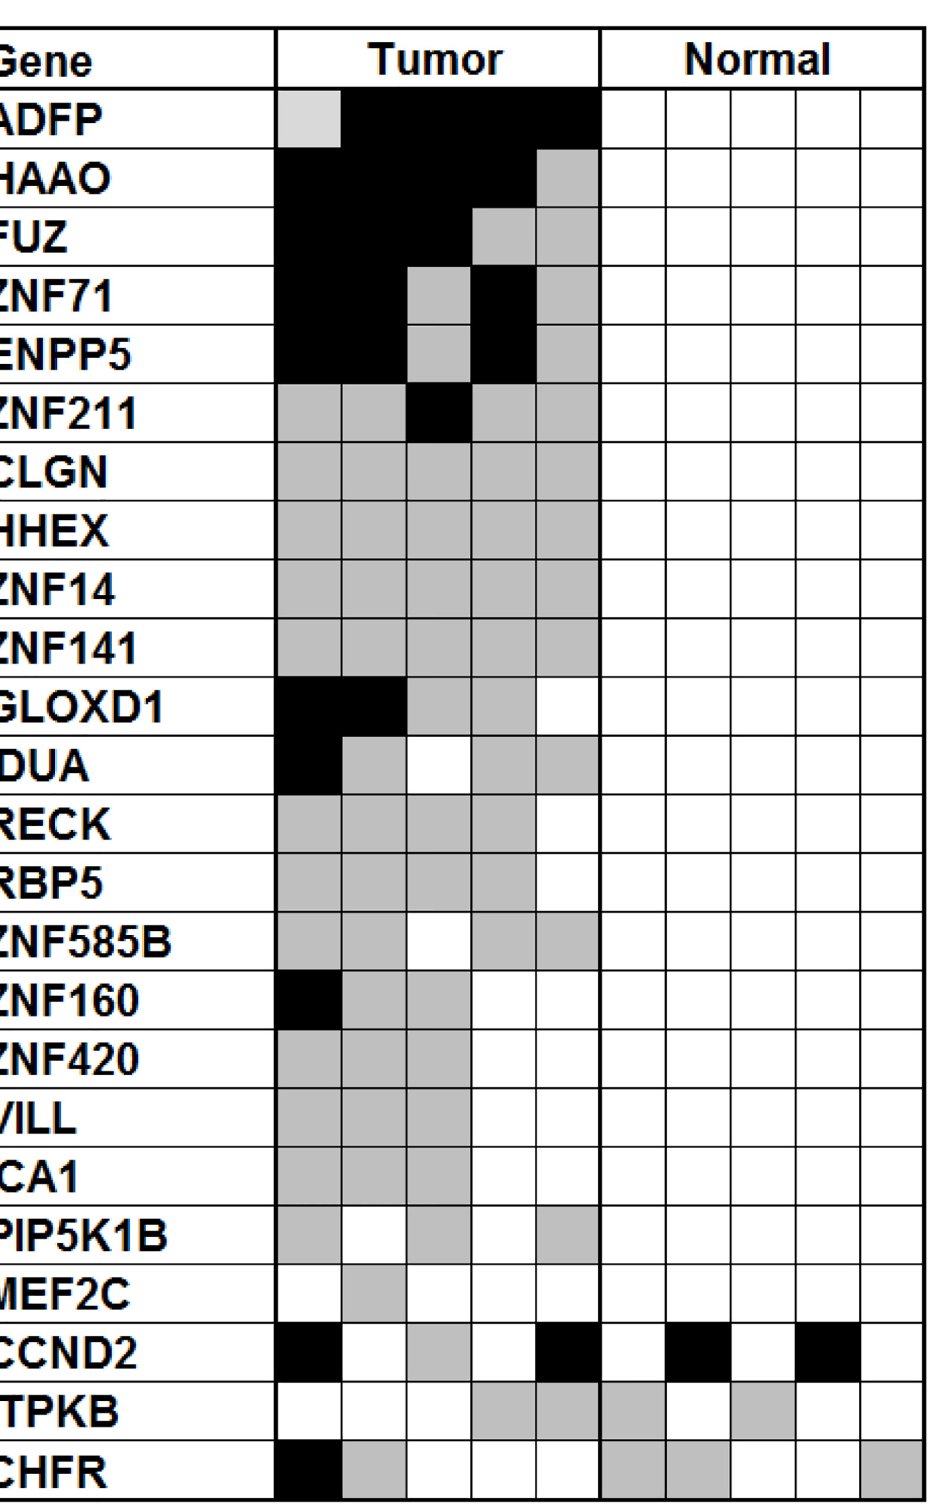
Fig 2. Promoter DNA hypermethylation of prospective tumor suppressor genes. Bisulfite sequencing results are shown in 5 HNSCC tumor samples and 5 normal tissues from the original discovery cohort for the 24 top-scoring candidate genes (Table 1). Shaded black boxes represent completely methylated promoters, gray boxes represent hemimethylated promoters, and white boxes represent unmethylated promoters. doi:10.1371/journal.pone.0142148.g002 PLOS ONE | DOI:10.1371/journal.pone.0142148 November 6,